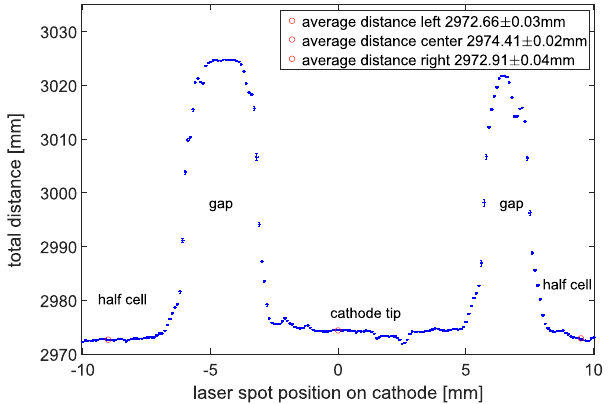
FIG. 5. Result of a cathode localization measurement. The distance values on the left and right of the center represent the distance of the measuring device to the half cell around the cathode, while the middle part represents the distance to the cathode ’ s front tip. Since the size of the scanning laser spot is on the order of 2 – 3 mm the gaps in between cathode and half cell seem larger than they are in reality ( < 1 mm).